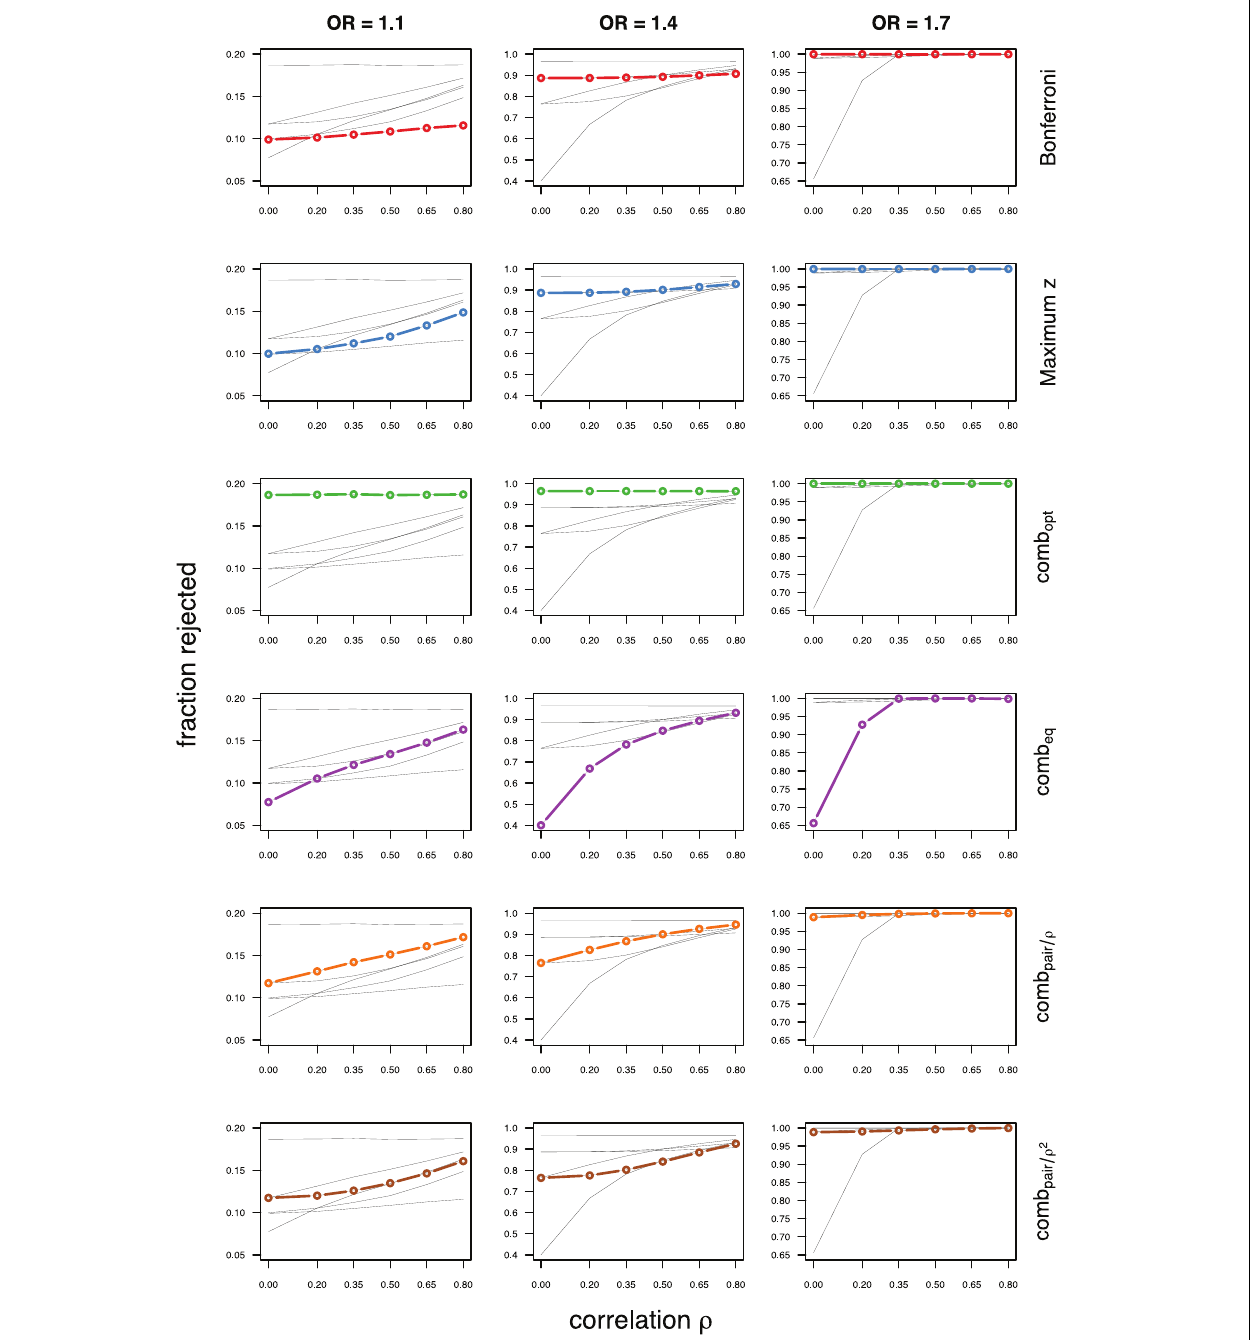
FIGURE 5 | Comparing analytic strategies in the setting with autoregressive correlation structures, assuming equal minor allele frequencies of 25% in a block of 5 markers. The fraction of rejected null hypotheses of no association (power, y-axis) in 50,000